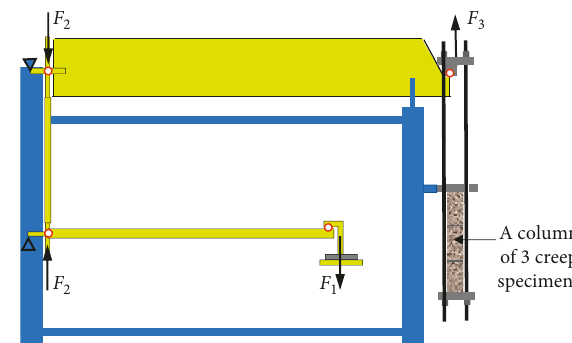
Figure 6: Creep device concept: F 1 : force of suspension weights; F 2 : force transmitted by the moment arm; F 3 : force applied on the creep